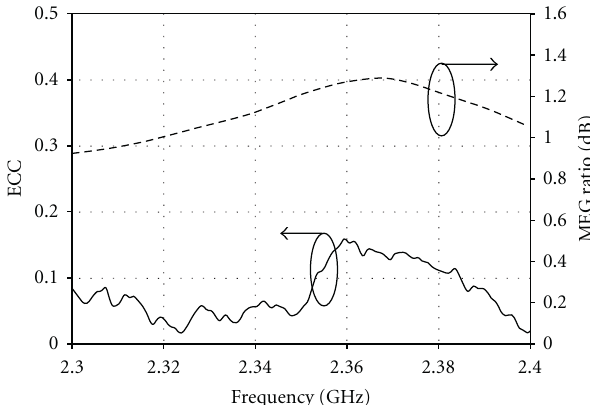
Figure 11: Measured ECC and MEG ratio